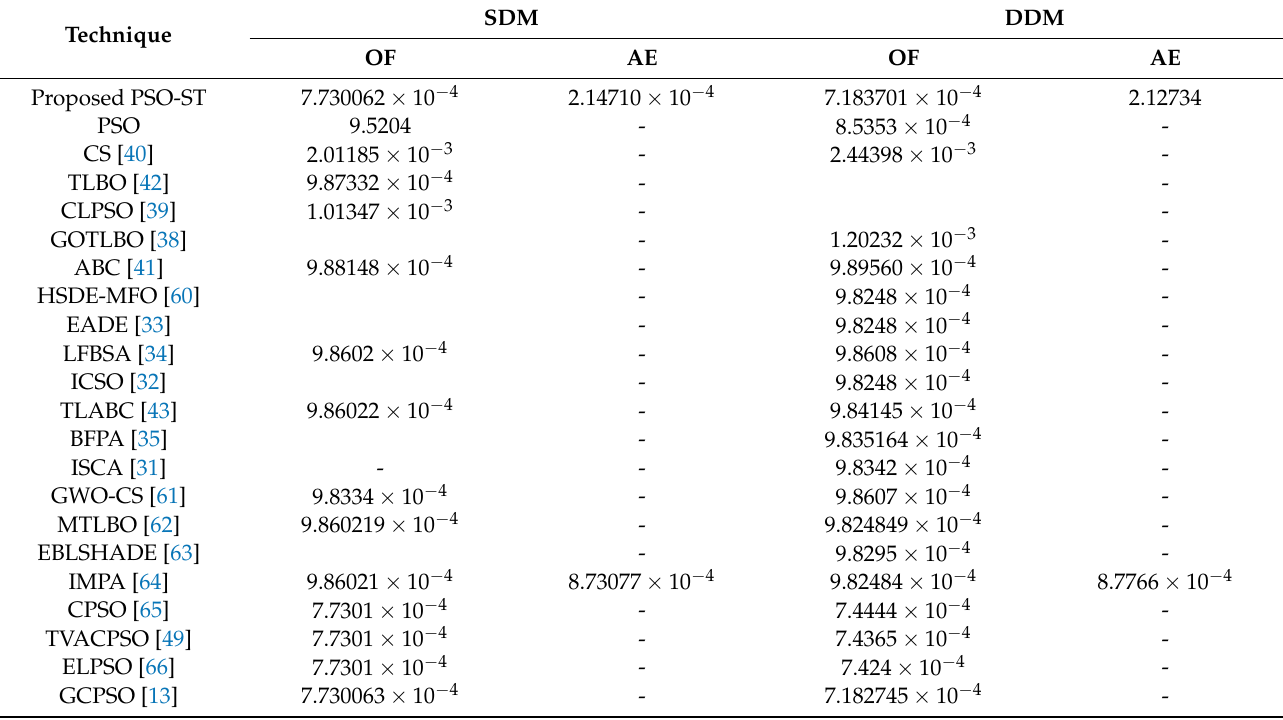
Table 6. Obtained optimal results and its comparison with literature available techniques proposed technique for SDM and DDM PV cell. (- indicates not provided by